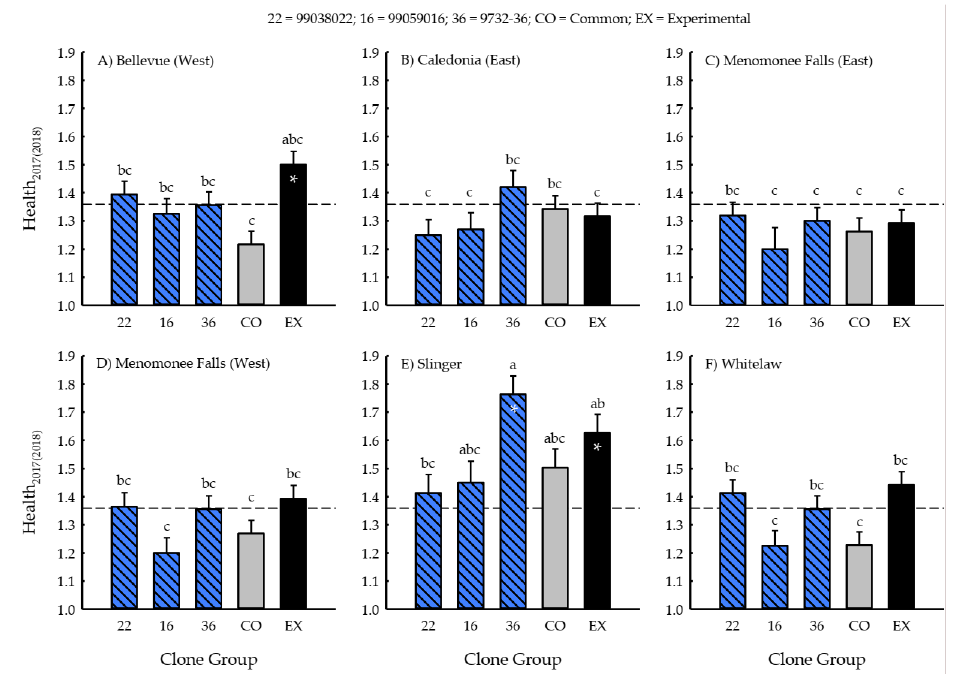
Figure 4. Tree health ( ± one standard error) determined after the 2018 growing season of three clone groups (i.e., NRRI = 22, 16, 36; Common; Experimental; see Table 3 for definitions) tested in six phytoremediation buffer systems (i.e., phyto buffers) established in 2017 (i.e., the 2017 Buffer Group) in the Lake Michigan watershed of eastern Wisconsin, USA. The dashed line represents the overall mean, and asterisks indicate means different than the overall mean at p < 0.05. Bars with different letters across all buffer × clone group combinations are different at p < 0.05. See Section 2 for complete tree health definitions (1 = optimal health, 2 = good health, 3 = moderate health, 4 = poor health, and 5 =